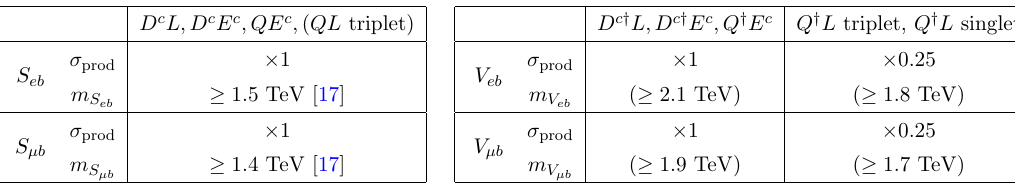
eb and S (cid:22)b . Both occur only